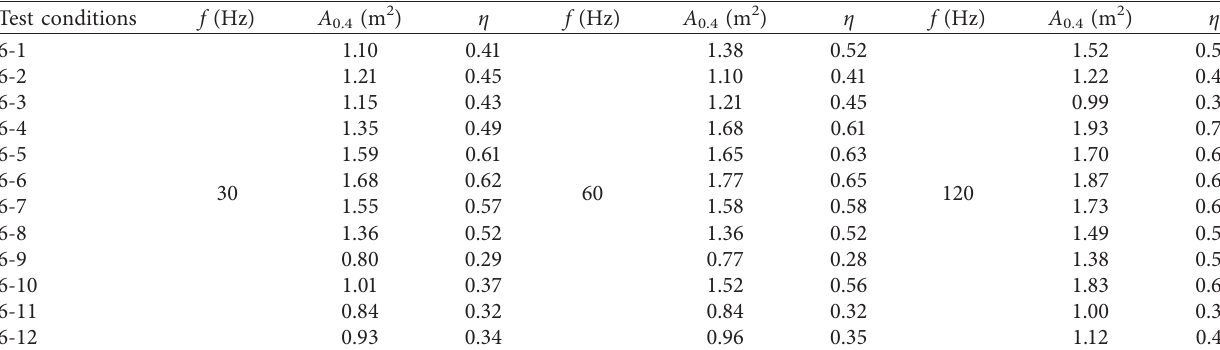
Figure 15: Amplitude reduction ratio contour map for test conditions (a) 6-1, (b) 6-5, and (c) 6-12. Table 16: List of vibration isolation